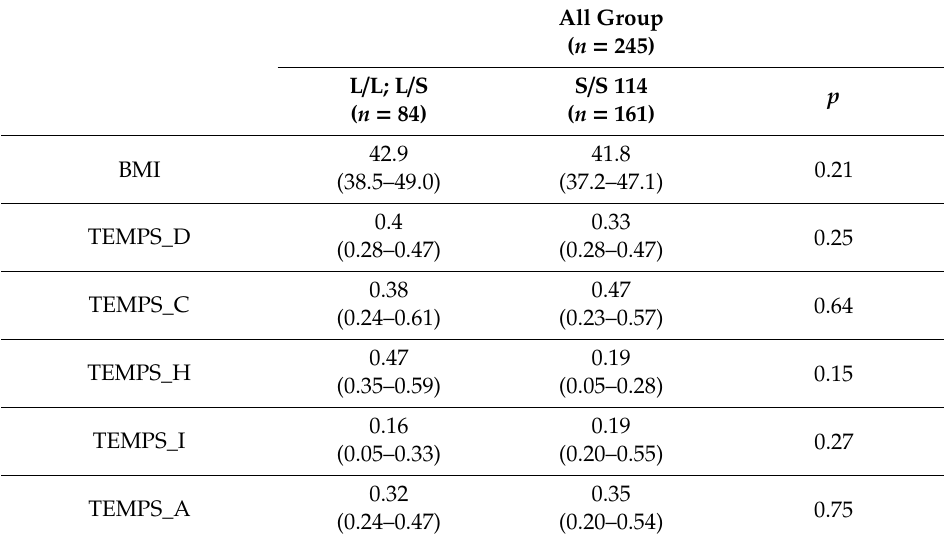
Table 5. DRD4 polymorphisms and TEMPS-A results in subgroups of women and men.